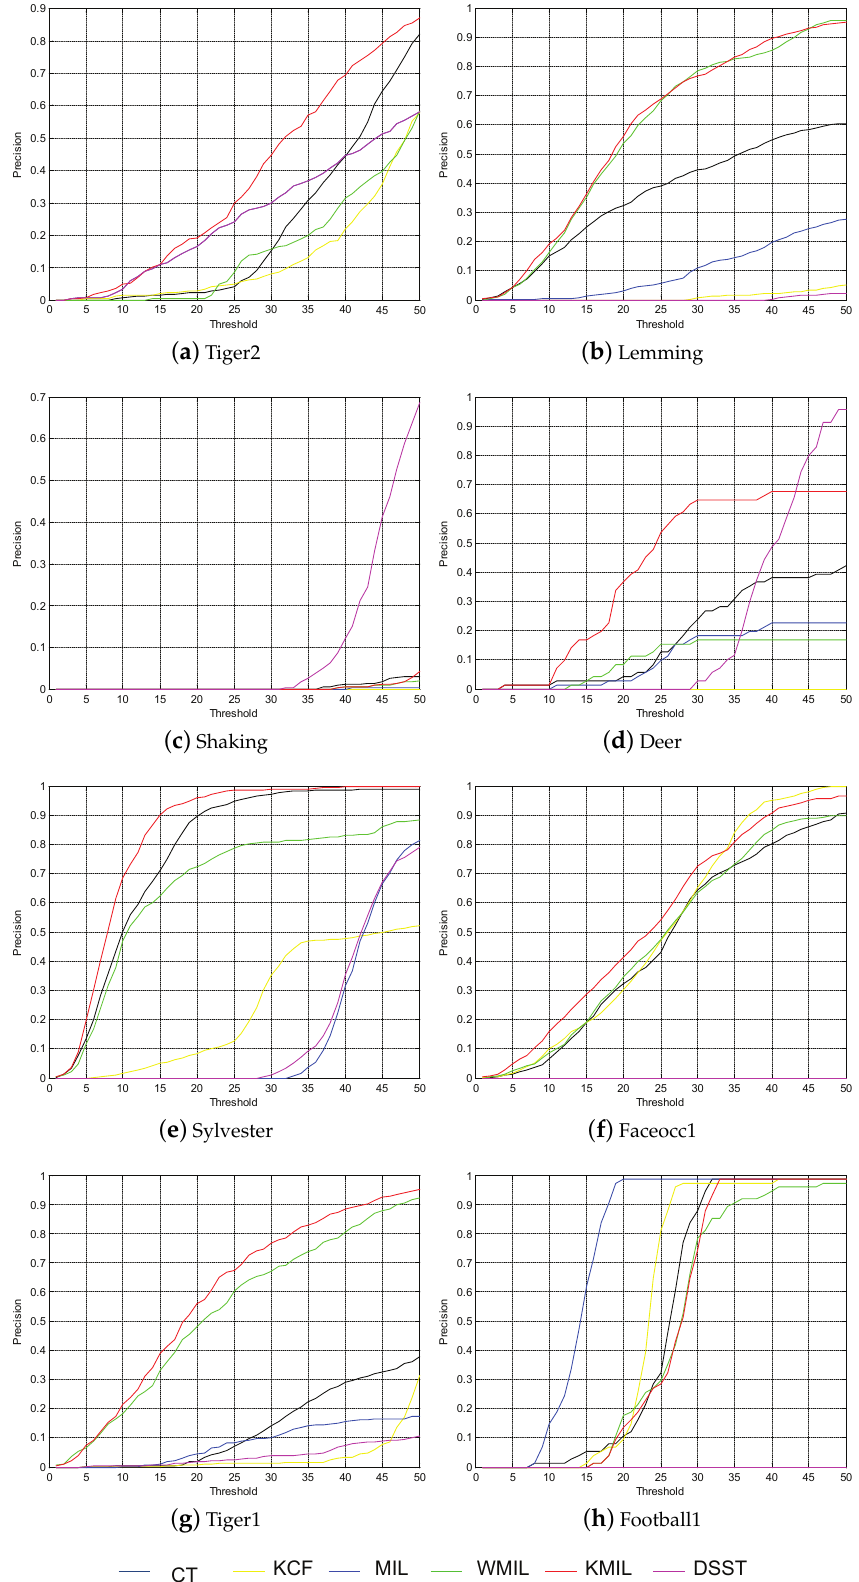
Figure 3. Precision plot for sequences: “Tiger2”, “Lemming”, “Shaking”, “Deer”, “Sylvester”, “Faceocc1”, “Tiger1”,